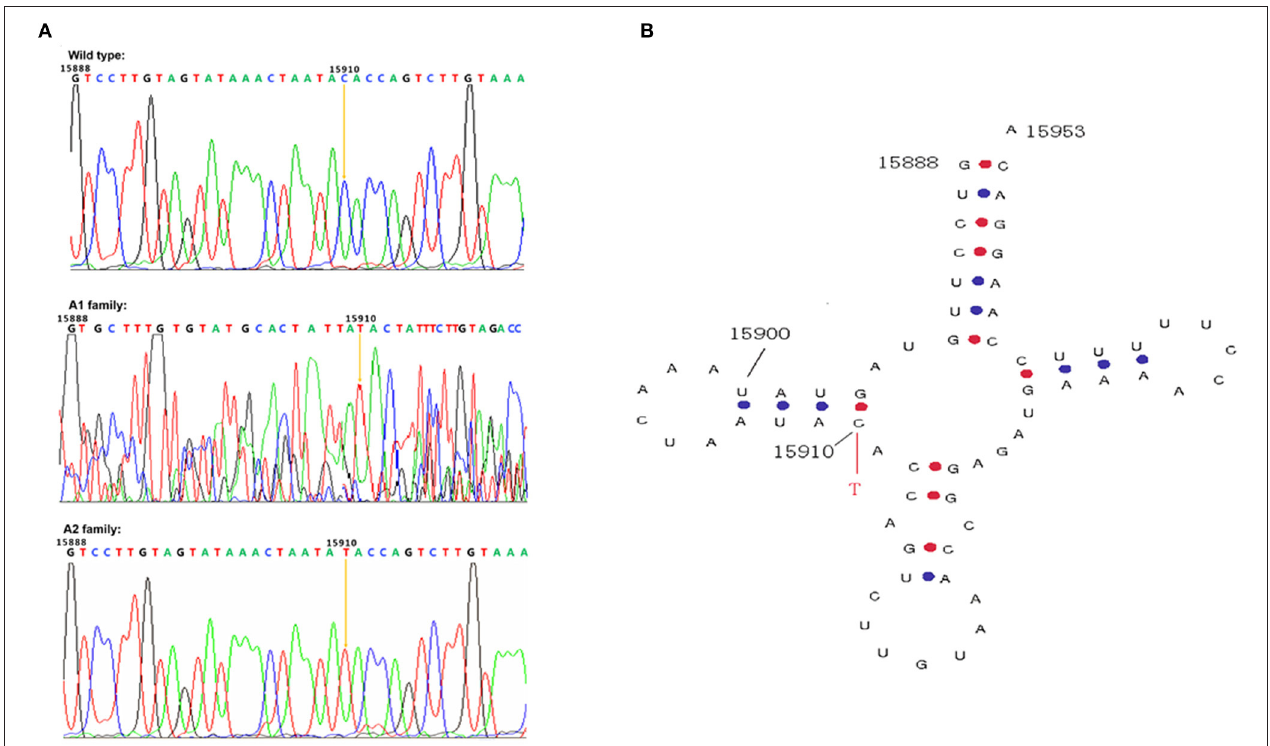
FIGURE 3 | Mitochondrial gene sequencing and secondary structure of tRNA Thr 15910. (A) The mitochondrial tRNA Thr C > T mutation in families A1 and A2; (B) The first base pair in the D-loop formed by the C at 15910 and G at 15897 is disrupted by the tRNA Thr C > T mutation.